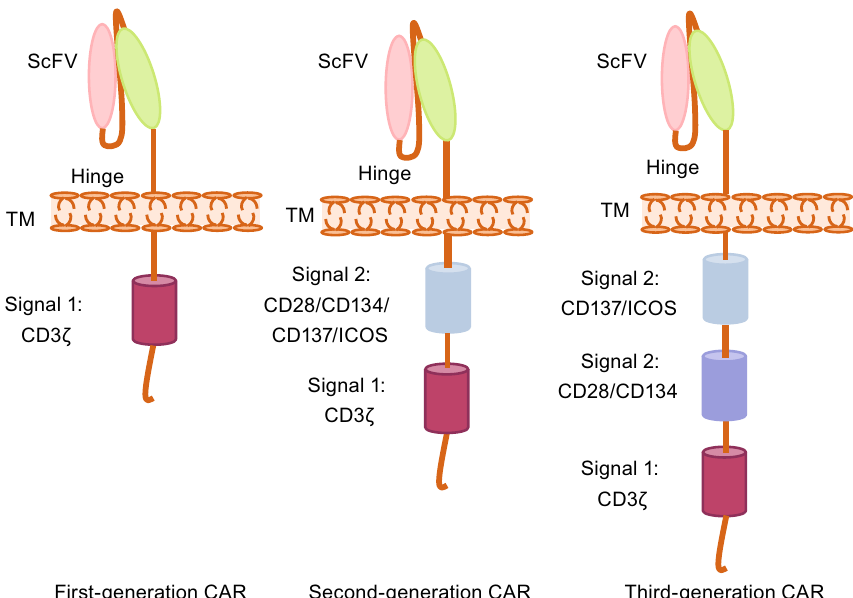
Figure 1. CAR design. CARs are engineered membrane proteins that consist of three main components: an extracellular antigen- recognition domain, a hinge and transmembrane domain, and an intracellular Tcell activation signaling domain. First-generation CARs haveonlyaCD3 ζ signalingdomainintheintracellularpartprovidingsignal1forTcellactivation.Second-generationCARshaveanextra signal2domainintheintracellulardomain.Third-generationCARshavethreedomainsintheintracellularpart,twosignal2domainsand one signal 1 domain. ScFv, single chain variable fragment; ICOS, inducible Tcell costimulator;